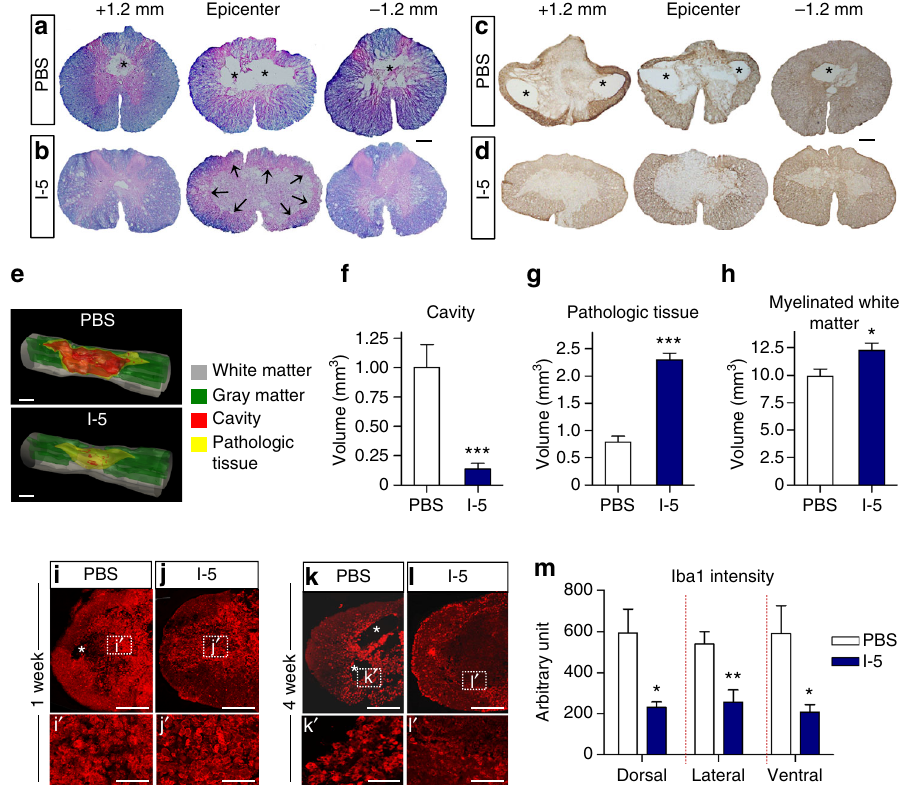
Fig. 3 Injection of I-5 hydrogel eliminates cystic cavities. a – d Absence of cavity spaces after I-5 injection. Representative images of transverse spinal cord sections stained with eriochrome cyanine and eosin ( a , b ) or GFAP antibodies ( c , d ). Spinal cord sections were obtained from animals 4 weeks after PBS ( a , c ) or I-5 injection ( b , d ). The sections shown are from the epicenter and 1.2 mm rostral (+1.2 mm) or caudal ( − 1.2 mm) to it. Asterisks indicate cystic cavities. In animals with I-5 injection, there was no sizable cavity observed. Instead, eosin-stained ECM-like tissue was observed in the central epicenter region, of which boundary was indicated by black arrows ( b ). Scale bars represent 200 μ m. e Three-dimensional reconstructions of the spinal cord tissues from animals with PBS or I-5 injection. Scale bars represent 1 mm. f – h Quanti fi cation graphs showing the volumes of cavity ( f ), pathologic tissue ( g ) and myelinated white matter ( h ). * and *** indicate p < 0.05 and p < 0.001, respectively, by two-tailed Student ’ s t -test. N = 8 animals per group. Error bars represent the SEM. i – l Representative images of transverse spinal cord sections at the epicenter stained with an Iba1 antibody. The sections were obtained from animals 1 week ( i , j ) or 4 weeks ( k , l ) after injection. Magni fi ed images of the boxed regions are shown in i ʹ – l ʹ . Asterisks indicate cystic cavities. Scale bars indicate 200 μ m ( i – l ) and 50 μ m (i' – l'). m Graph showing quanti fi cation of the Iba1 immuno fl uorescence intensity at 4 weeks after injection (5 weeks after injury). The fl uorescence intensity was measured in three ROIs: one each in dorsal, lateral, and ventral regions containing the border between the residual white matter and damaged tissue with or without cavities at the epicenter. * and ** indicate p < 0.05 and p < 0.01, respectively, by two-tailed Student ’ s t -test. N = 6 animals per group. Error bars represent the